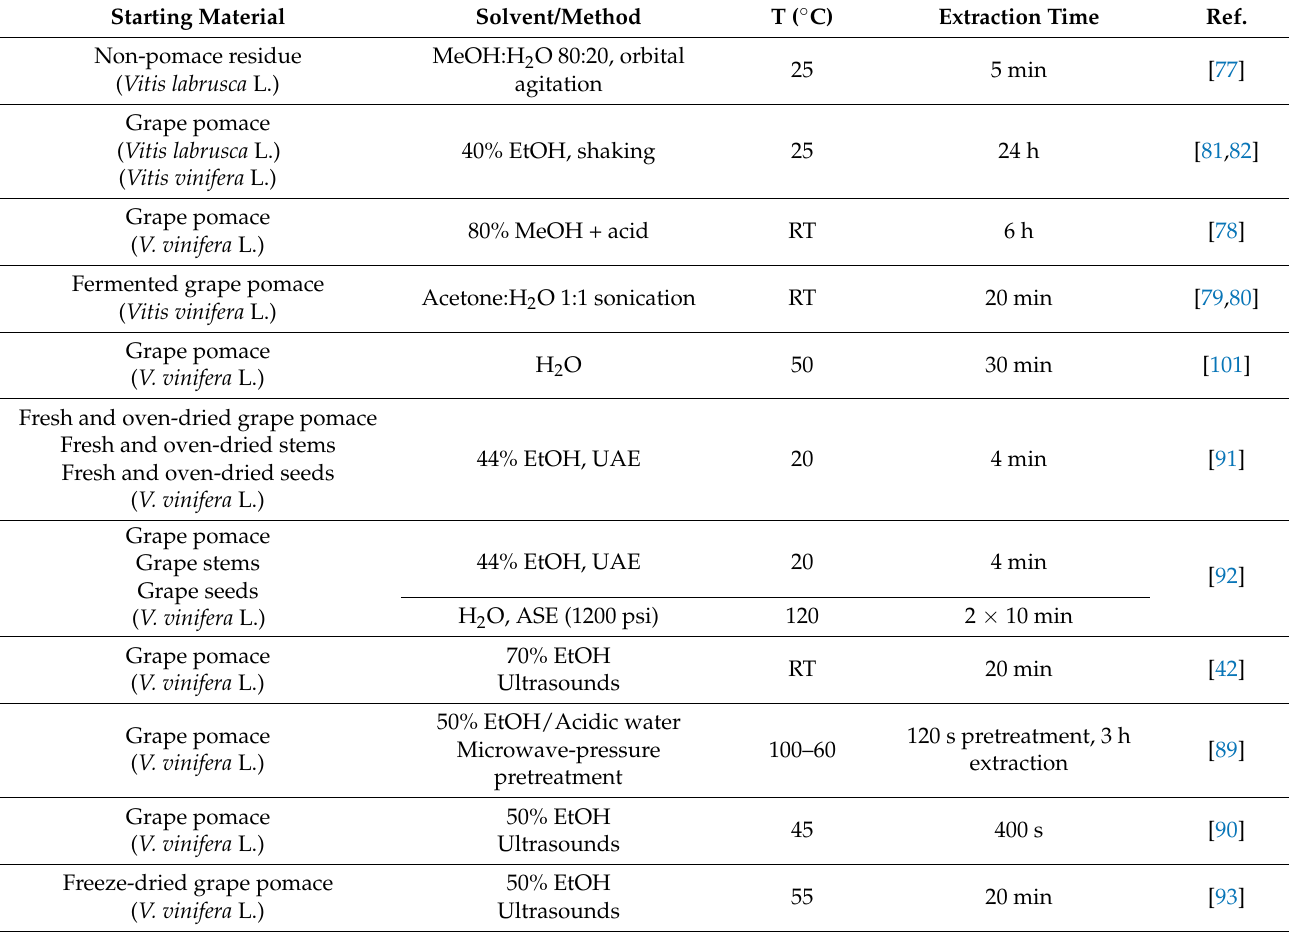
Table 1. List of the extraction